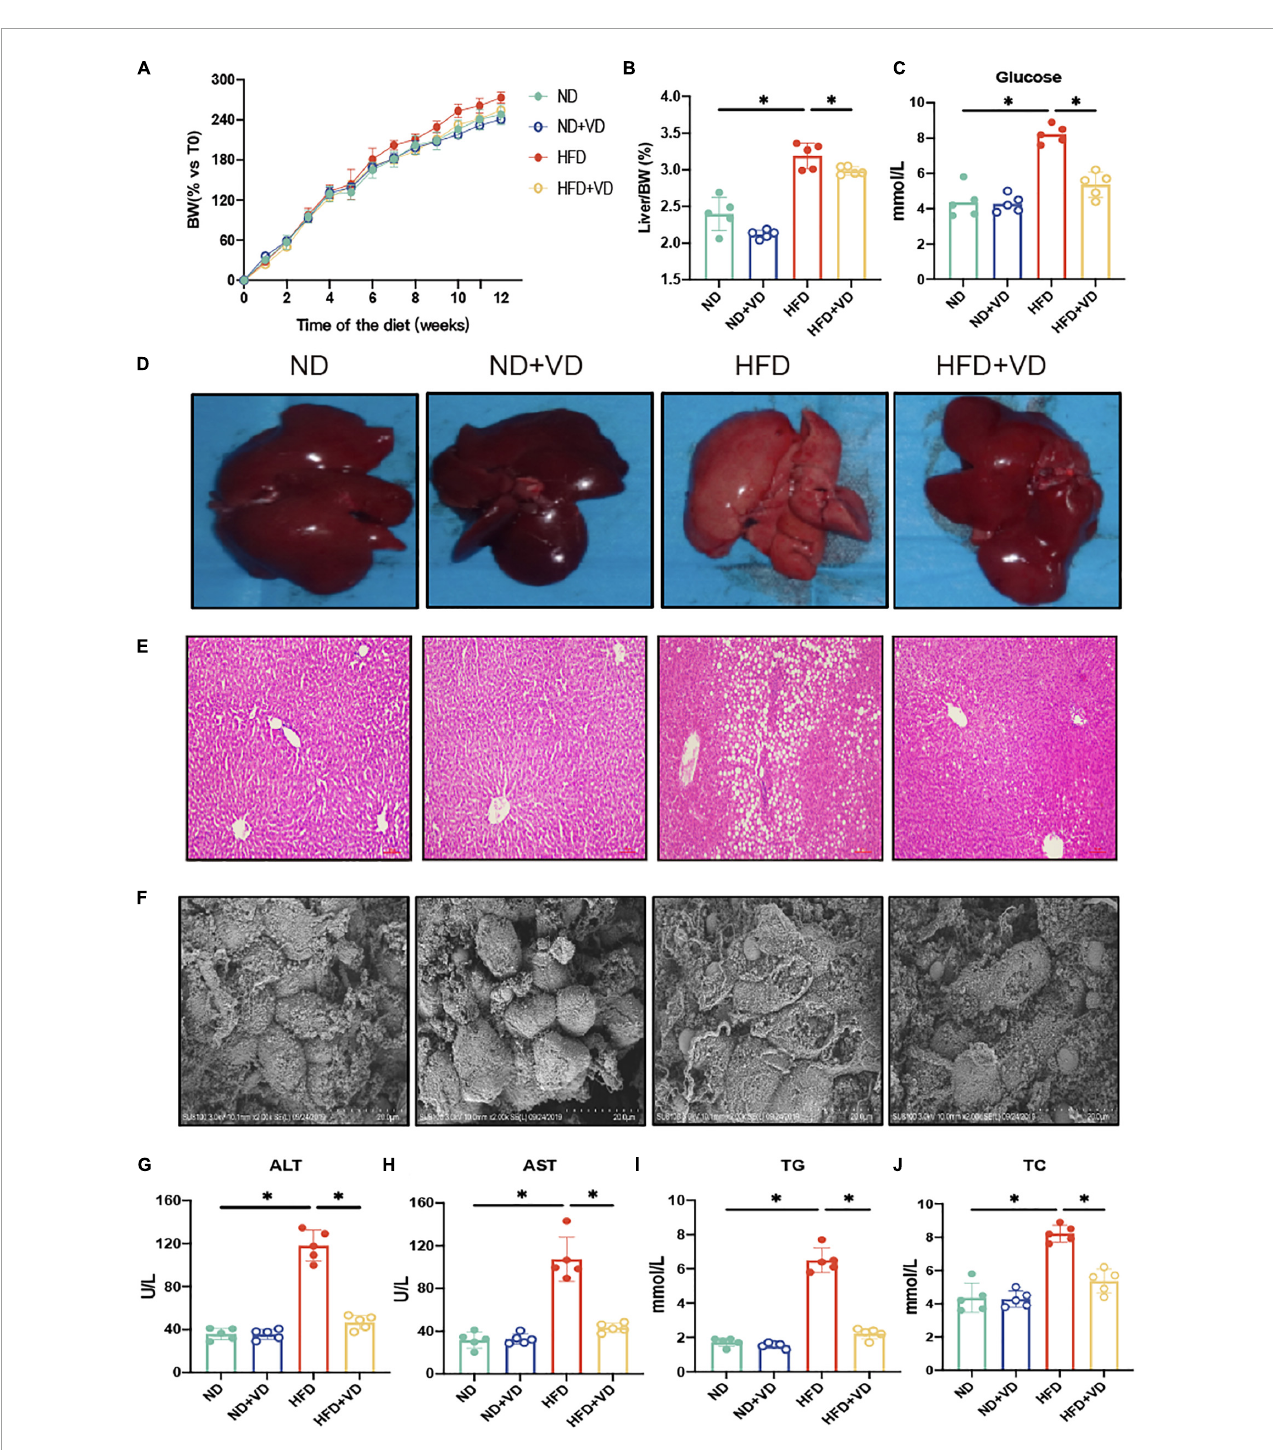
FIGURE1 Vitamin D (VD) supplement alleviates high-fat diet (HFD)-induced non-alcoholic fatty liver. (A) The body weight (BW) of male rats fed indicated diet was measured weekly for 12 weeks and expressed as percentage vs. time 0. Data are mean values ± SEM ( n = 5). (B,C) The liver organ index and fasting blood glucose in four groups. (D–F) Representative gross liver morphology, hematoxylin–eosin (H&E)-stained liver sections, and electron microscope picture of the liver. (G–J) The plasma amlodipine besylate (ALT), amlodipine aspartate (AST), total cholesterol (TC), and triglyceride (TG) levels in indicated groups. ∗ P < 0.05. P -values are derived from ordinary two-way ANOVA followed by Tukey’s multiple-comparison